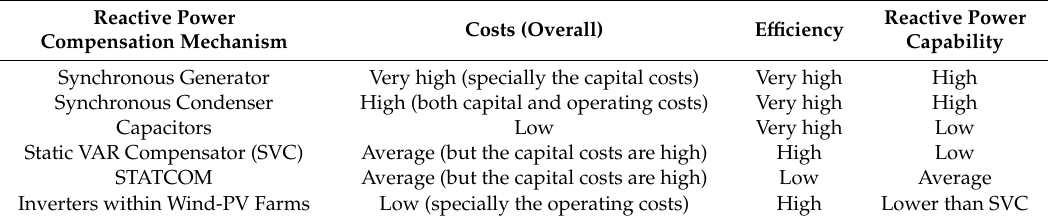
Table 1. Reactive Power Compensation